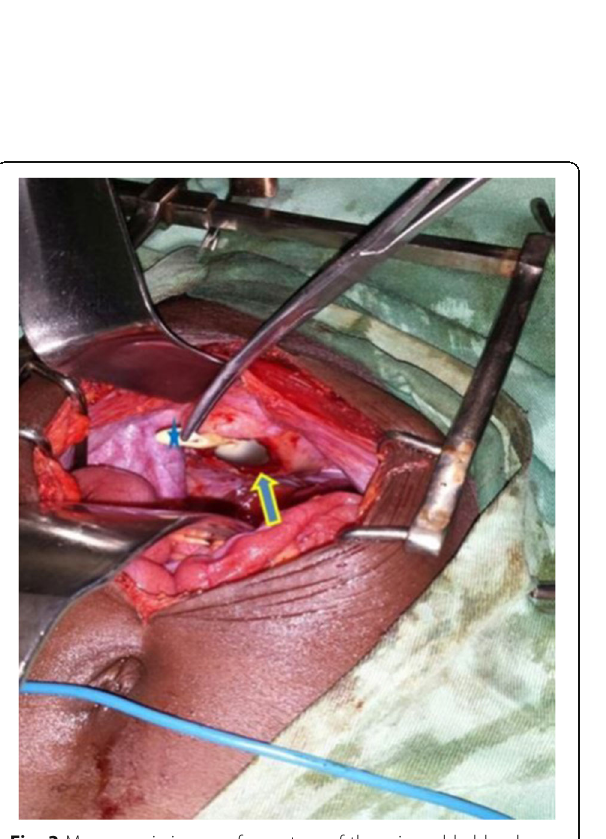
Fig. 4 Macroscopic image of a linear wound of the left thigh sutured, with a flow of bright